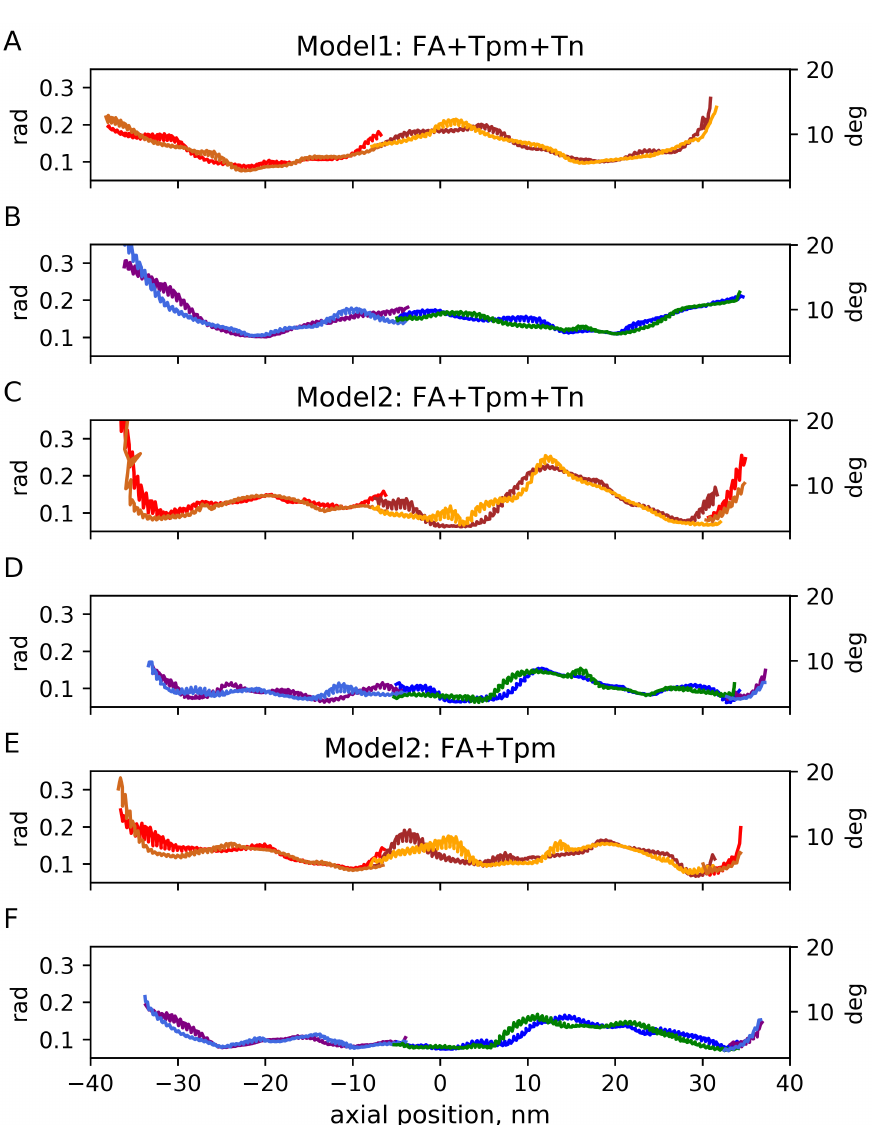
Figure 3. Time-averaged angular fluctuations (standard deviations, SD) of Tpm strands 1 (red/light brown and brown/orange; ( A , C , and E ) panels) and 2 (purple/light blue and blue/green; ( B , D , and F ) panels) with respect to long actin helices 1 and 2,